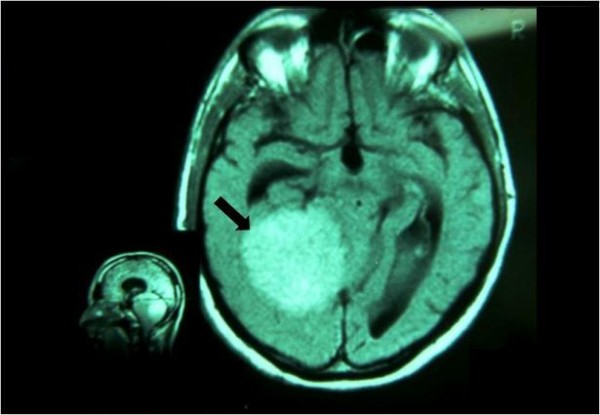
Magnetic Resonance Imaging (MRI). The patient's MRI scan shows a large meningioma, 8 cm in diameter (arrow) with lateral displacement of the brainstem.